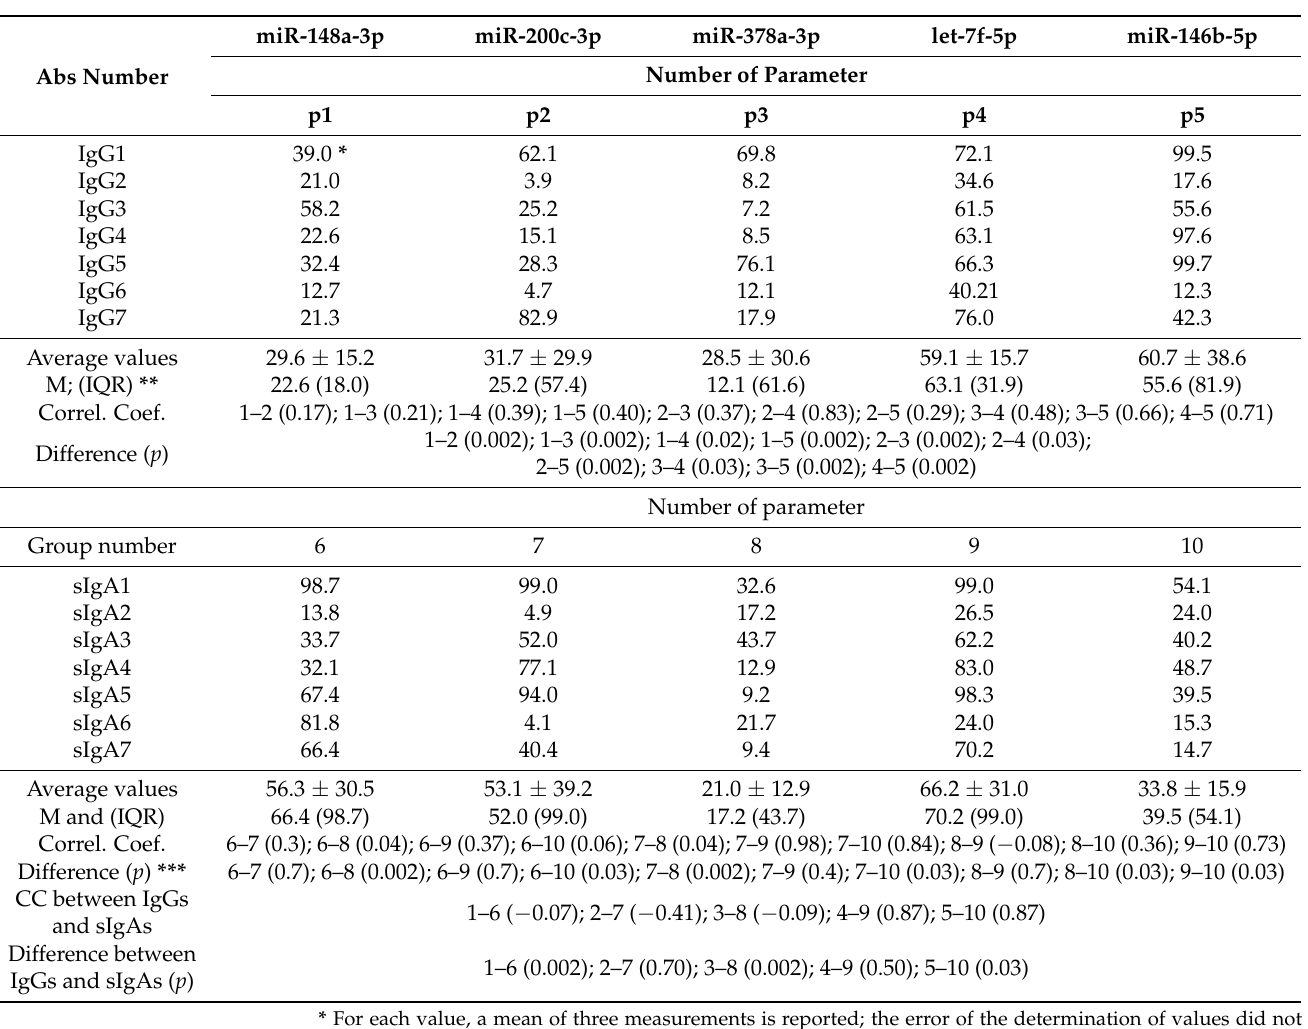
Table 3. Values of the relative activities of seven IgGs and sIgAs in the hydrolysis of five microR- NAs, their average values, and correlation coefficients (CCs), and differences between groups of parameters ( p